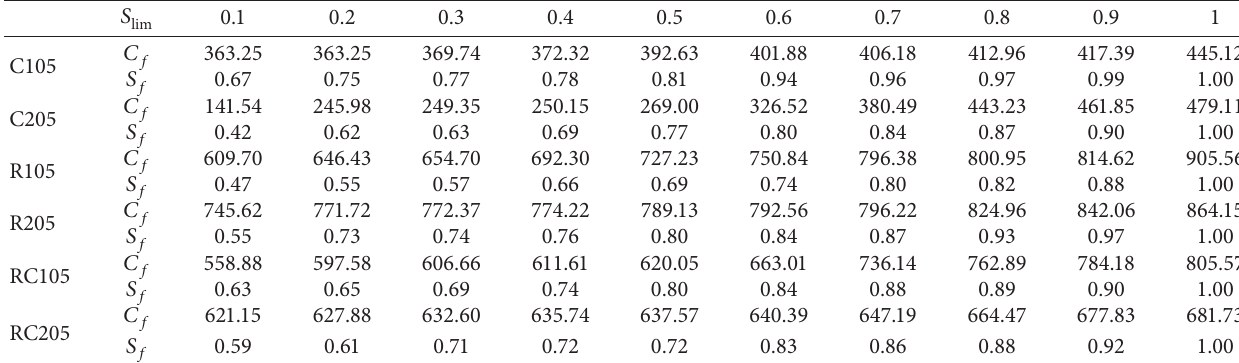
Table 3: Distribution costs and average satisfaction under different satisfaction